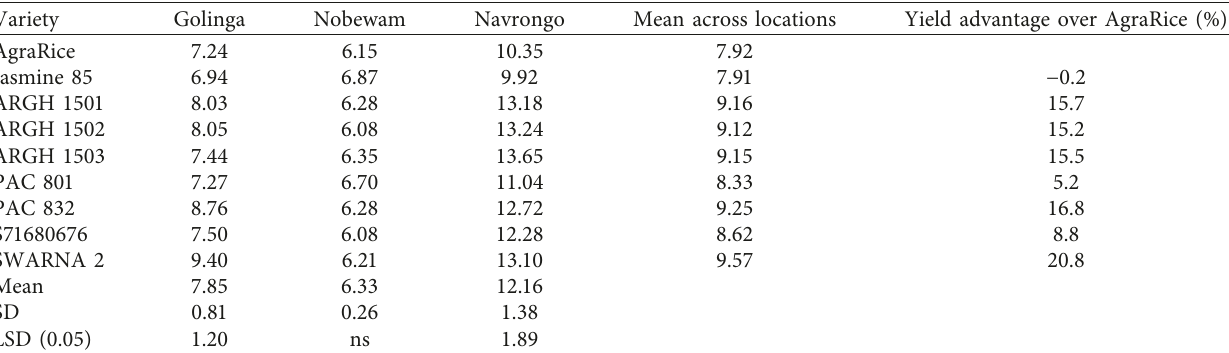
Table 6: Yield (t/ha) of hybrids and checks across locations in